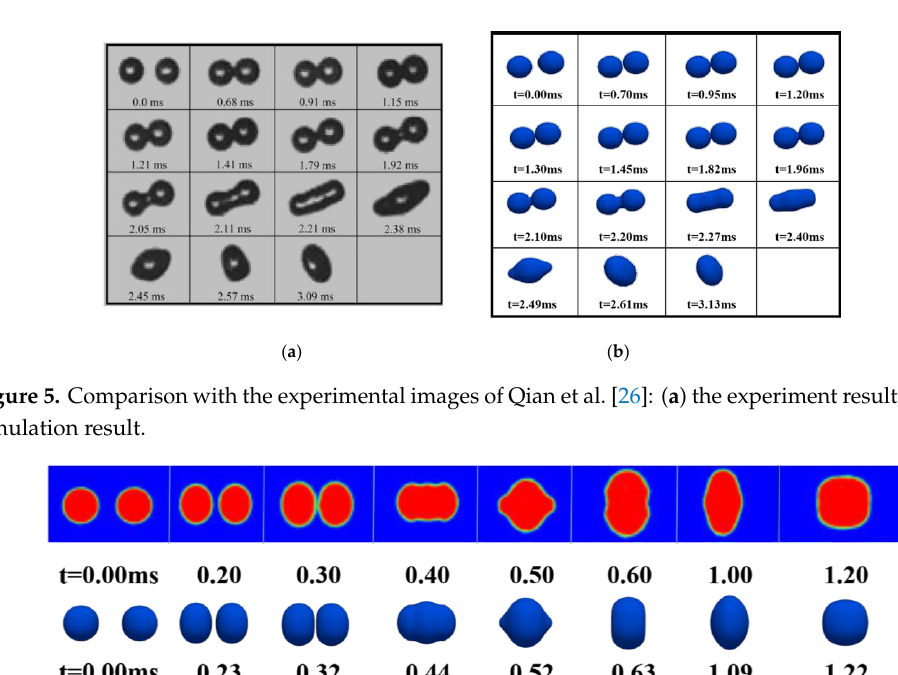
Figure 4. Verification of the grid independence under three different grid resolutions.